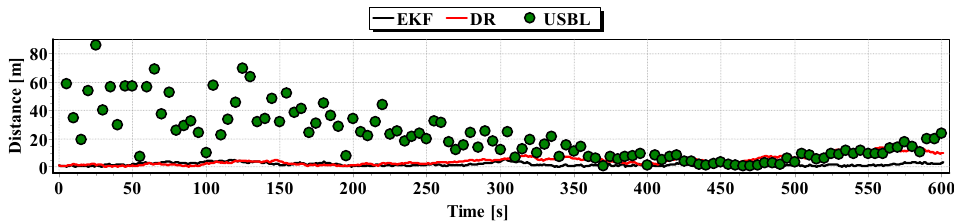
Figure 17. Graph of the reference position distance from the position estimated by EKF and DR methods and determined by the USBL system (single passage).